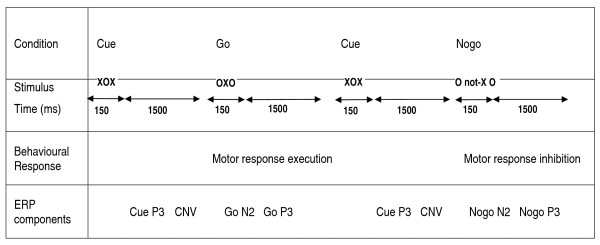
Flanker CPT-OX paradigm. The figure shows the relationship between task conditions and stimuli, behavioural responses and ERP components on cued go and nogo trials (10% each, 20% cues, 400 trials total). Note that the preparatory CNV following cues is sometimes also referred as a stimulus preceding negativity (SPN; preceding the go and nogo stimuli). See also Figure 1 in Banaschewski et al. 2004 for further detail.